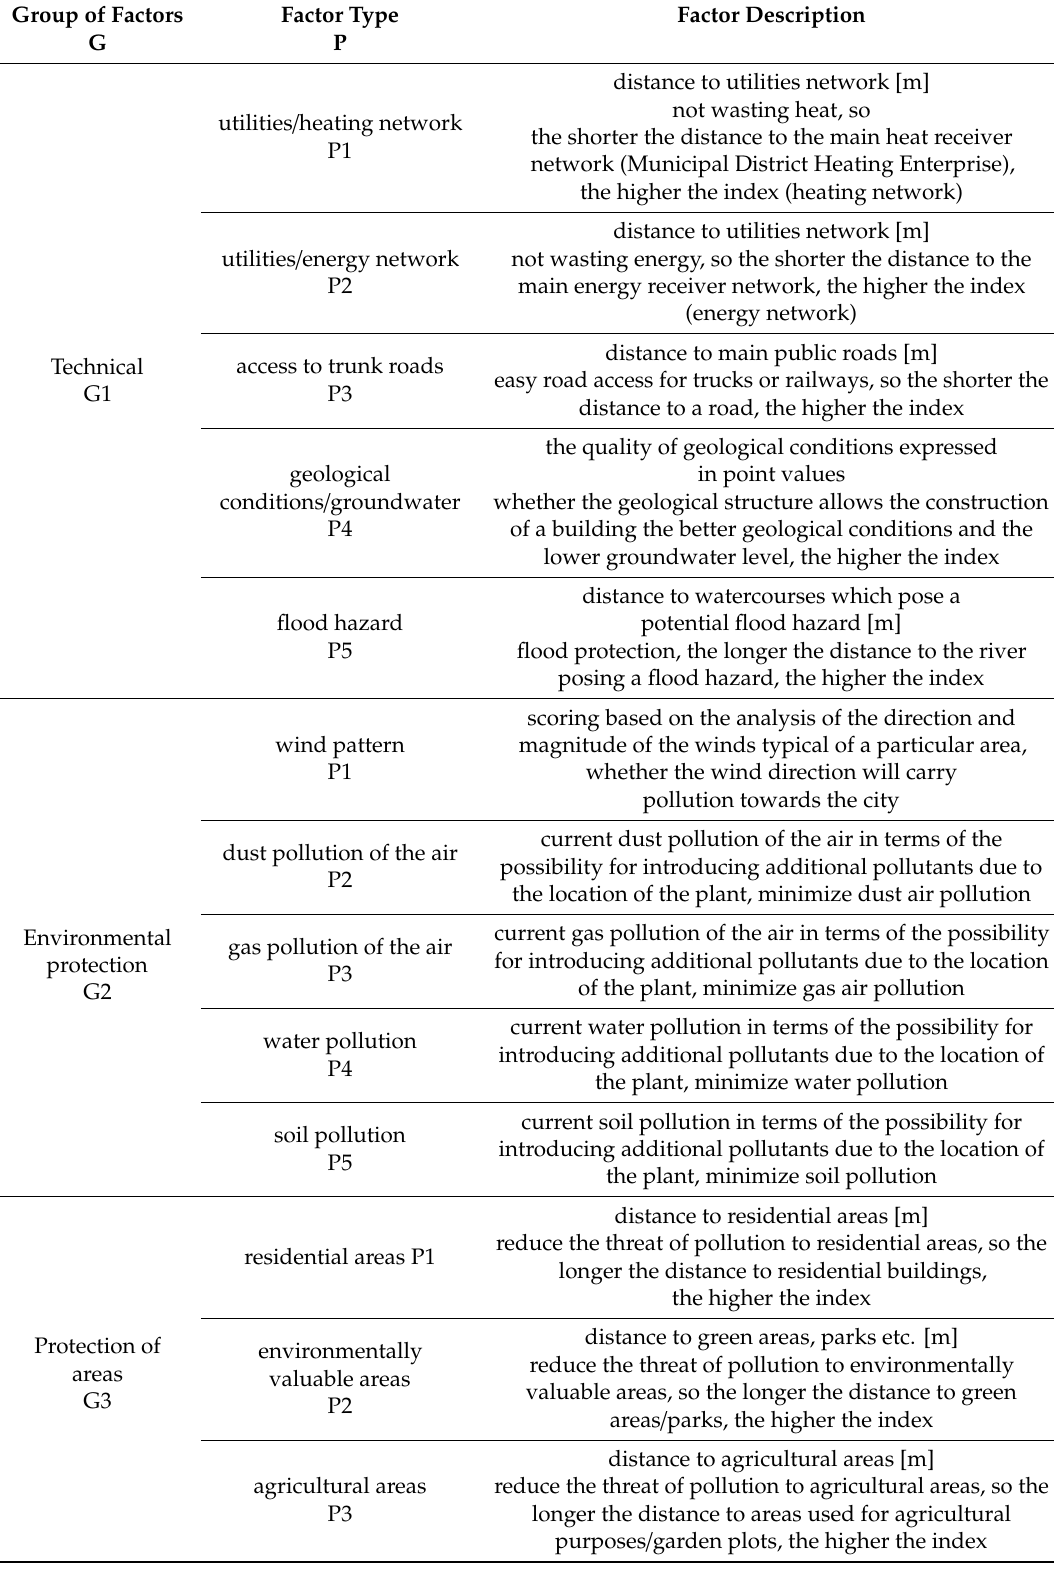
Table 4. Factors concerning the location of a municipal waste incineration plant. Group of